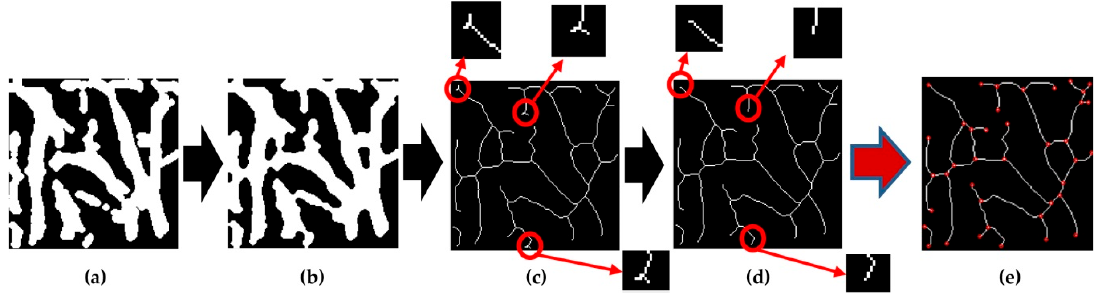
Figure 13. Minutia extraction: ( a ) vein image; ( b ) morphological closing operation; ( c ) morphological thinning; ( d ) morphological pruning; and ( e ) result of minutia extraction.